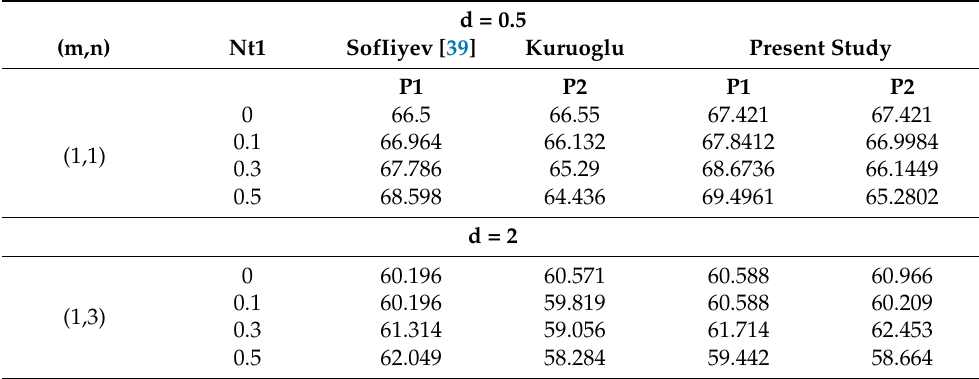
Table 2. Comparison of dimensionless excitation frequencies.